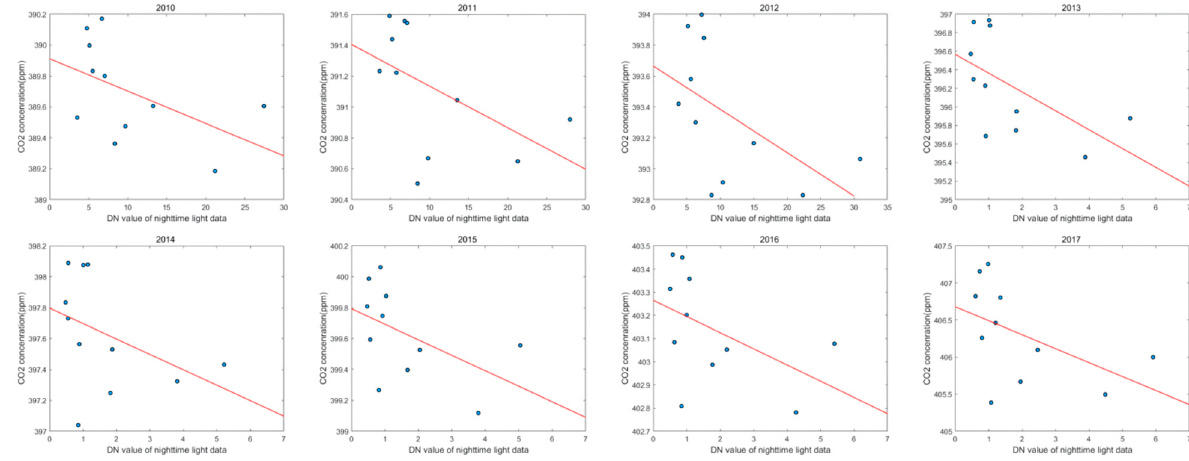
Figure A3. Correlation between annual NL data and CO 2 concentration of cities in Beijing-Tianjin- Hebei region from 2010 to 2017.